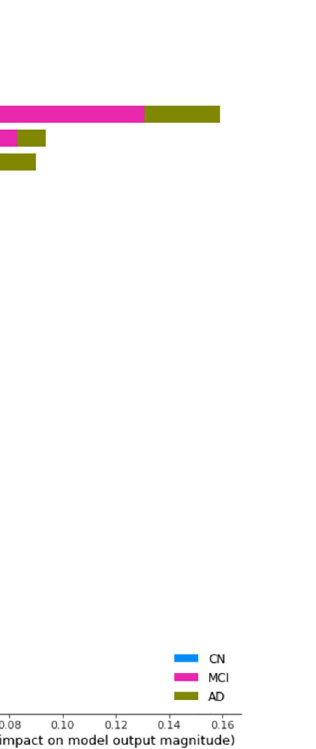
Fig 4. Mean absolute SHAP values computed from the XGB systems. Models trained with all features. Note that the label coloring for the CN, MCI, and AD classes is not consistent among experiments owing to rigid SHAP implementation. Long feature names have been trimmed for better legibility.